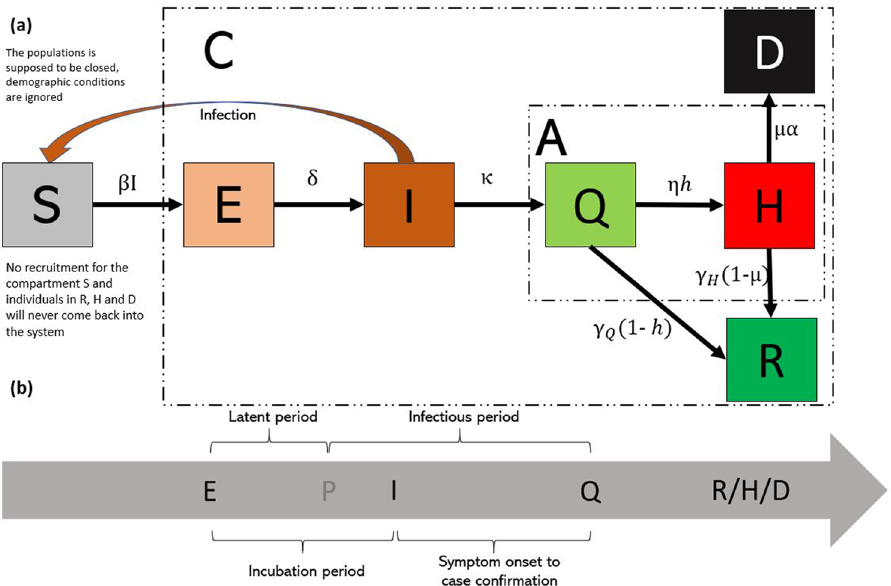
Figure 3. The SEIQRHD model used in this work. ( a ) SEIQRHD model. ( b ) Schematic representation of temporal evolution between compartments E, I and